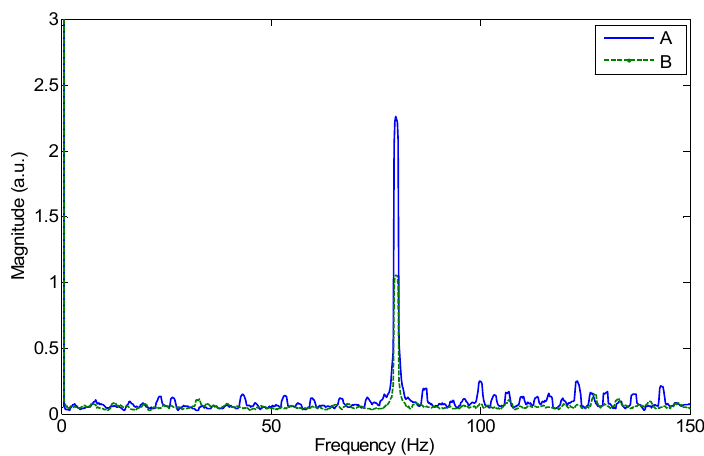
Figure 11. FFT data of 80 Hz tone measured at two different distances from the acoustic source, positions A and B, as shown in schematic of Figure 3.